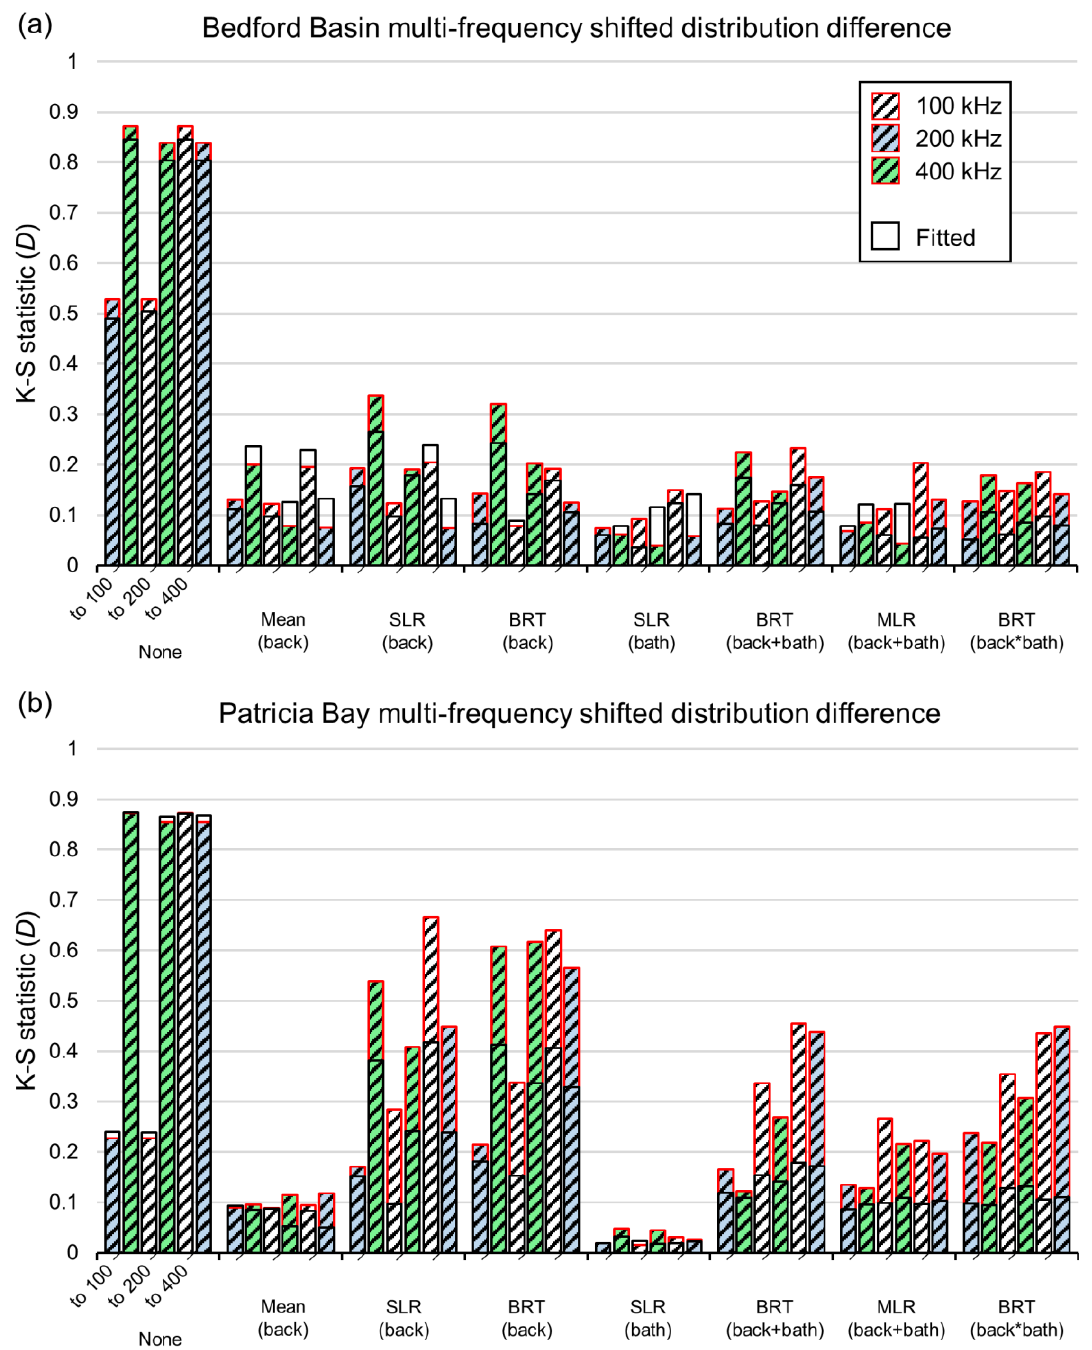
Figure 10. K-S statistic for shifted distributions of 100, 200, and 400 kHz backscatter corrected to other frequencies using seven bulk shift methods for ( a ) Bedford Basin and ( b ) Patricia Bay datasets. Table 4. Performance comparison of bulk shift methods at harmonizing datasets of different frequency for Bedford Basin and Patricia Bay datasets. Scores are average ranks for all frequencies and both datasets, relative to the other methods. Ranks are colour-coded from blue to orange for best to worst.